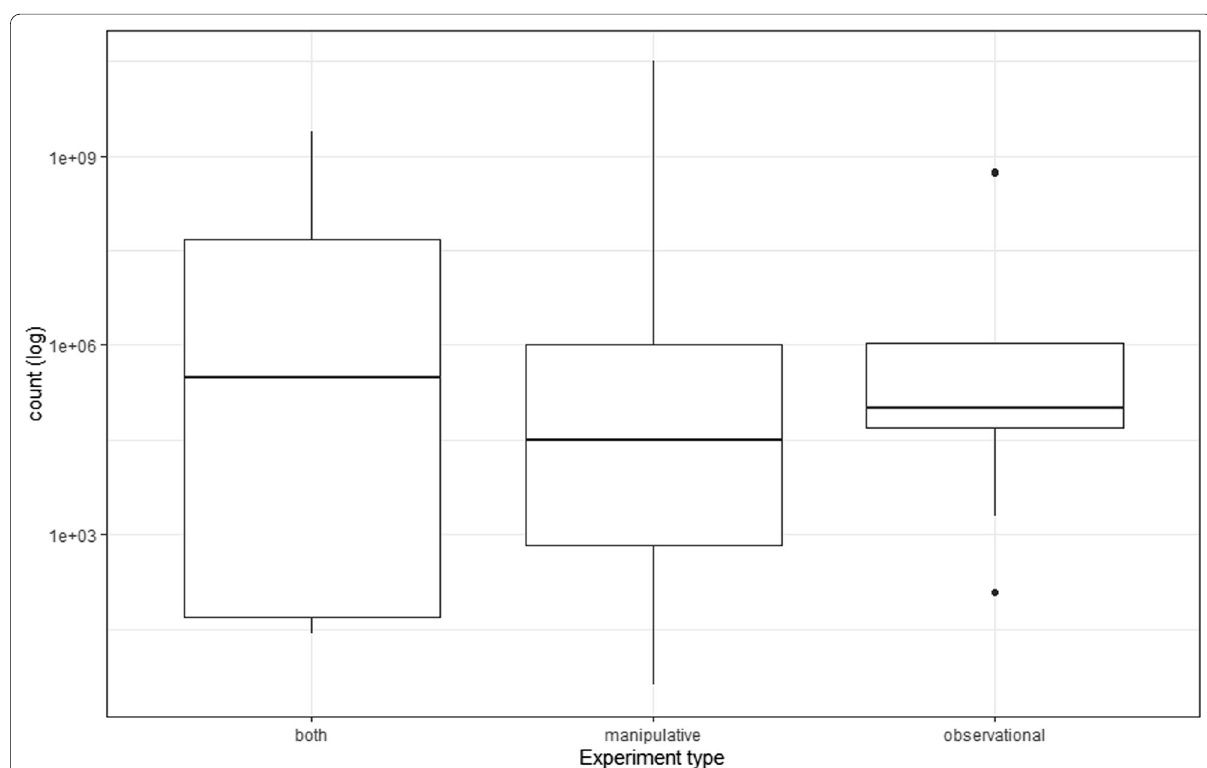
Fig. 2 Scope (ratio of grain to extent) of 43 papers in this review. Note the log scale on the y -axis. Scope here is the minimum per paper; some papers had different grain sizes; only the smallest grain was used for the scope calculations. Note that data were not always available to calculate scope, and I only calculated scope for areal studies; studies incorporating treatments by volume or linear treatments (e.g., along streams, or soil depths) were